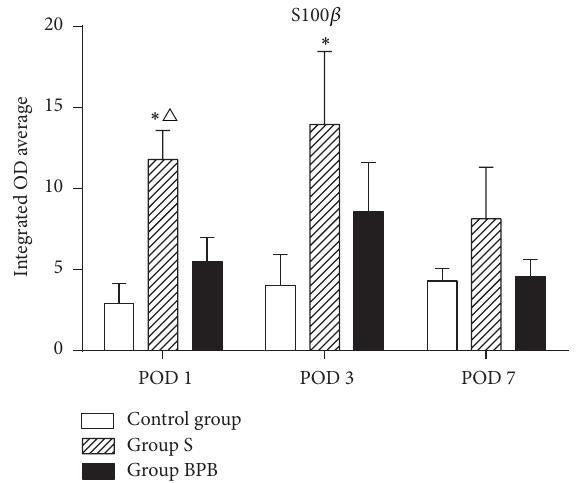
Figure 2: The average integrated OD of S100 𝛽 in hippocampus. Each bar represents mean ± SEM ( 𝑛 = 6 in each group). ∗ 𝑃 < 0.05 versus control group and 󳵻 𝑃 < 0.05 versus group BPB. POD = postoperative day.